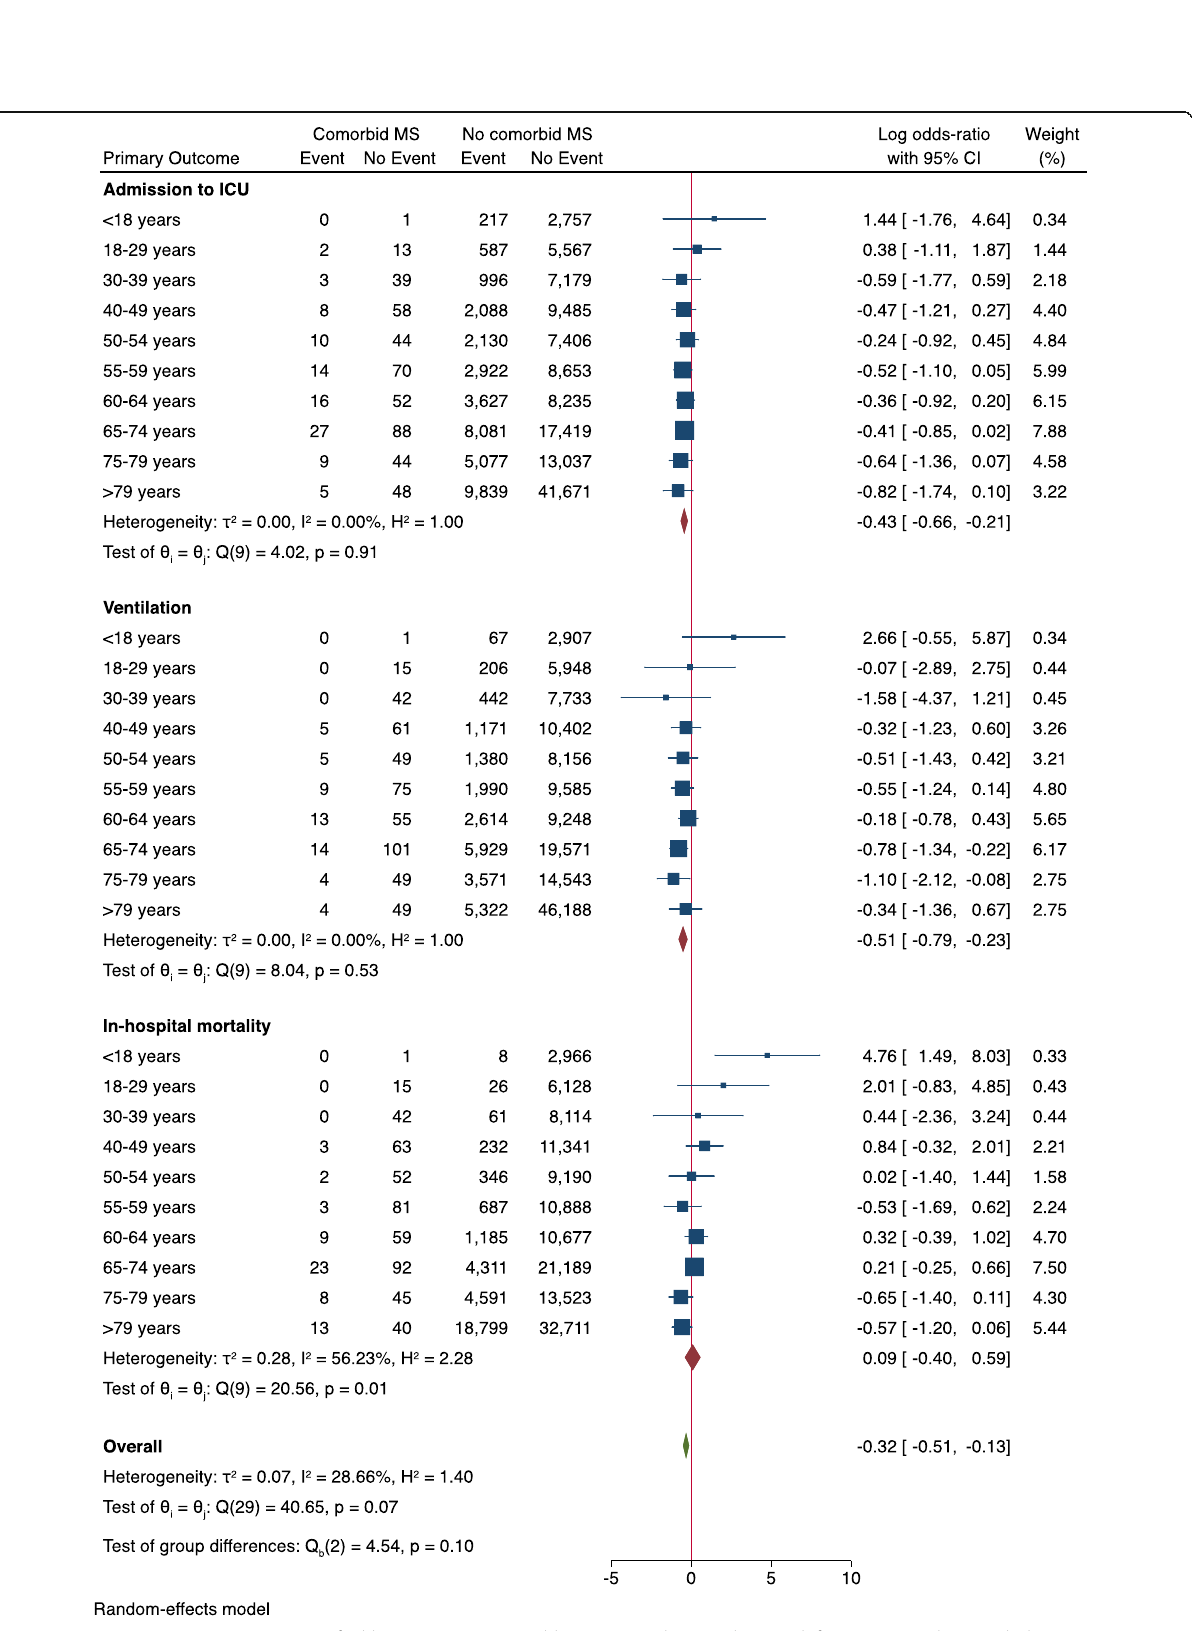
Fig. 3 Primary outcome parameters stratified by age-group. Log odds-ratio < 0 indicates a lower risk for patients with comorbid MS. Abbreviations: ICU = intensive care